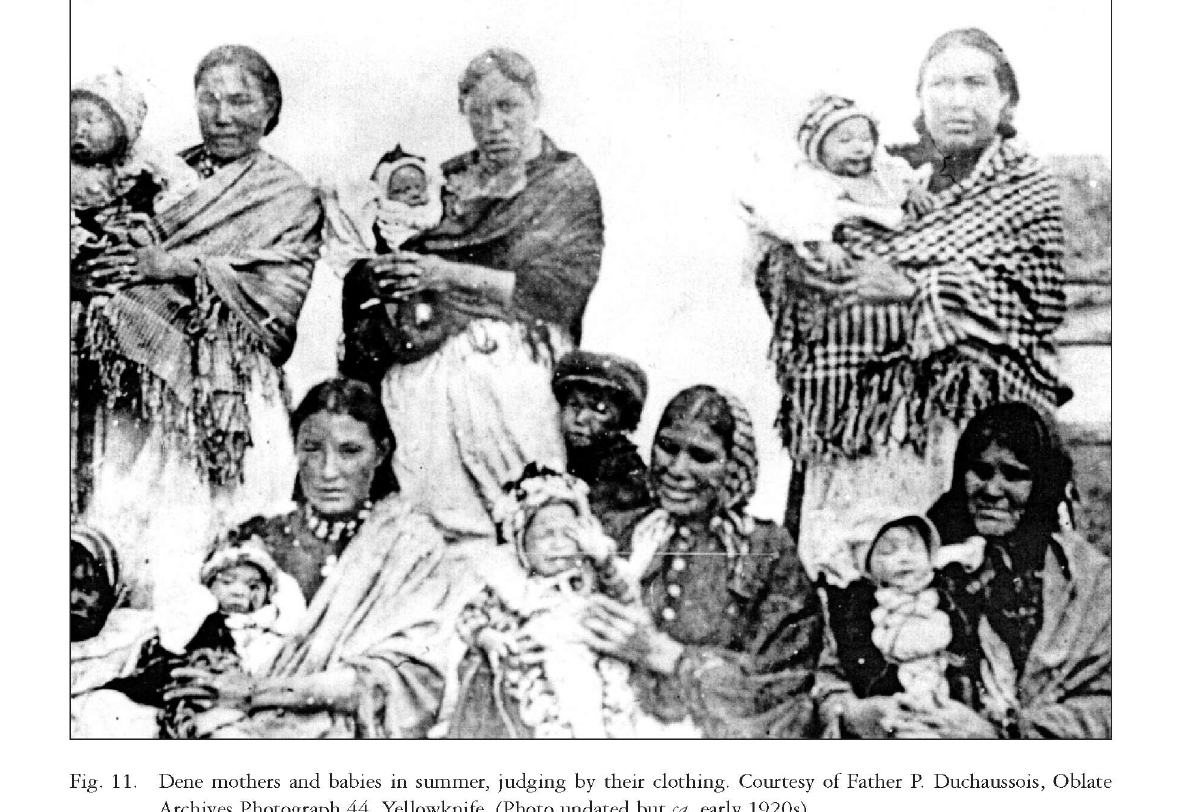
Fig. 11. Dene mothers and babies in summer, judging by their clothing. Courtesy of Father P. Duchaussois, Oblate Archives Photograph 44, Yellowknife. (Photo undated but ca. early